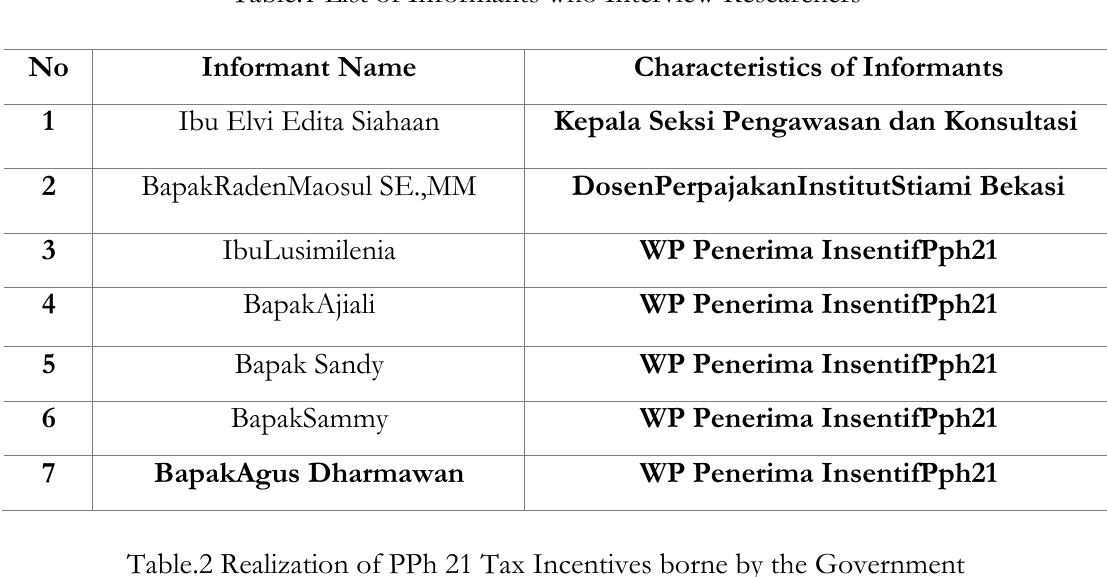
Table.2 Realization of PPh 21 Tax Incentives borne by the Government